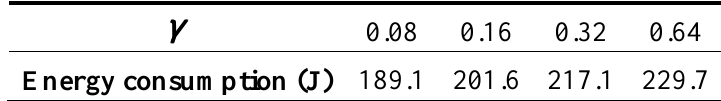
Table 4. Total energy consumption of WSN with different probability awakening parameter g